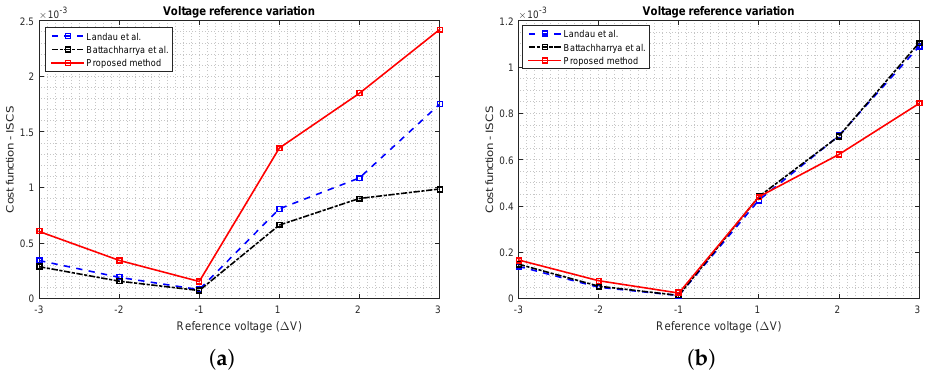
Figure 19. Cost function ISC when occurs the voltage setpoint variation. ( a ) Simulation and ( b ) Experimental test.